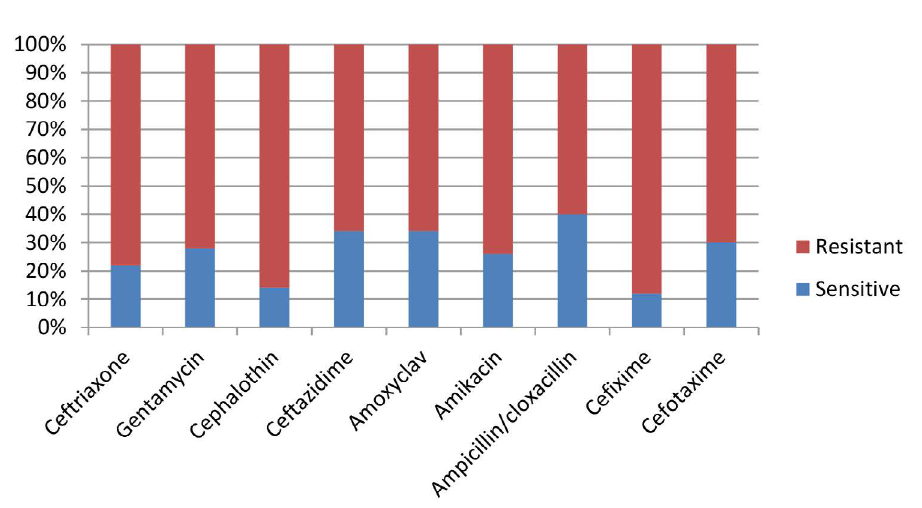
Fig. 2. Antibiotic sensitivity of isolates with highly diversified plasmid DNA (50 samples).